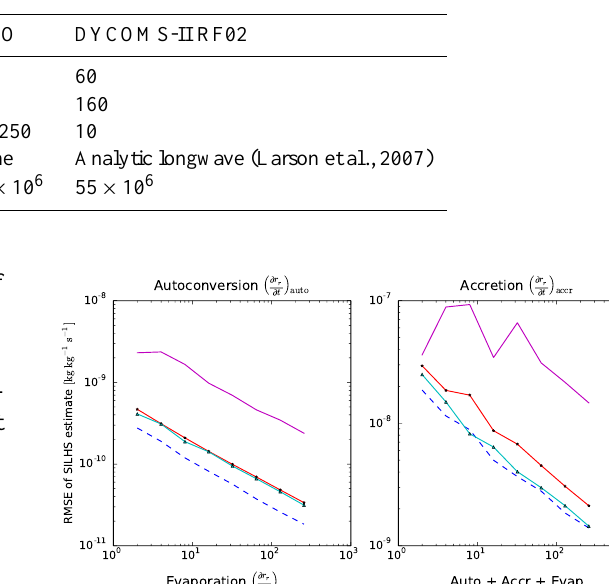
Table 2. Notable configuration settings for the RICO and DYCOMS-II RF02 simulations performed in this paper.